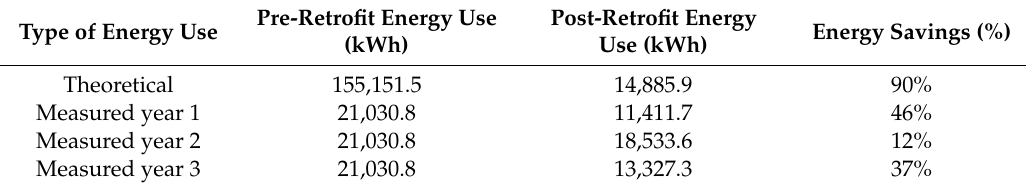
Table 2. Theoretical and measured primary energy use in kWh per year, and the resulting energy savings in